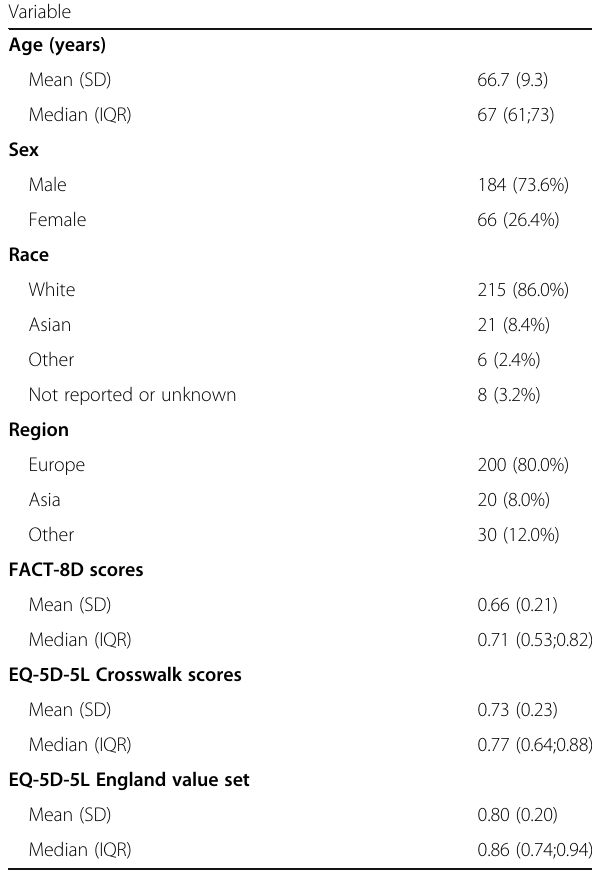
Table 1 Baseline demographic characteristics and EQ-5D and FACT-8D Index scores for patients included for analysis ( n = 250)